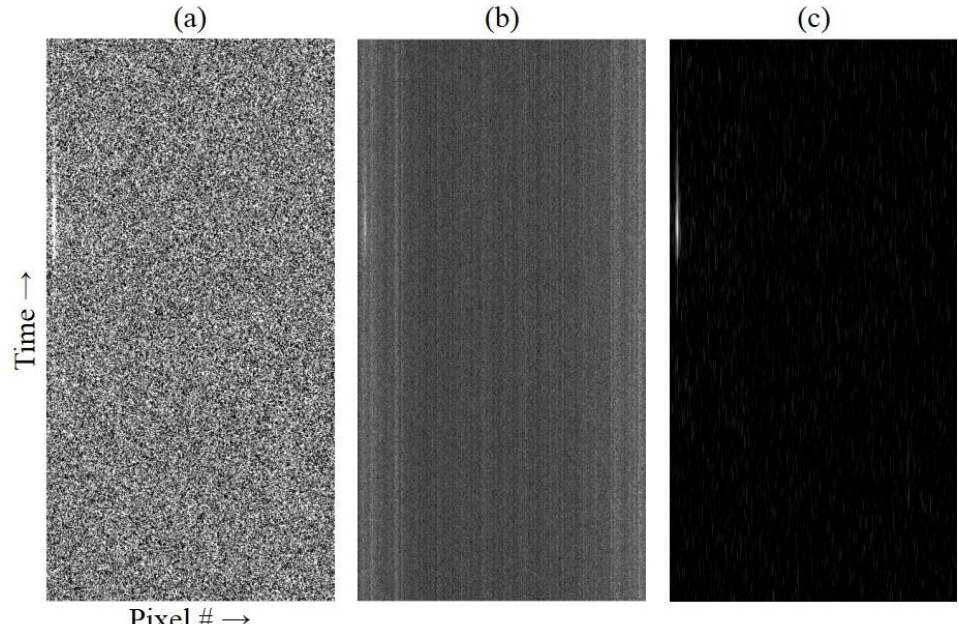
Figure 6. M-file script assessment of experimental fluorescence data. ( a ) The array has been reshaped and the background subtracted; ( b ) the data in (a) has been normalized; ( c ) a matched digital Gaussian filter has been applied to the data in (a) and the result normalized (contrast has been further enhanced to increase visibility). Only a portion of the total data collection time is